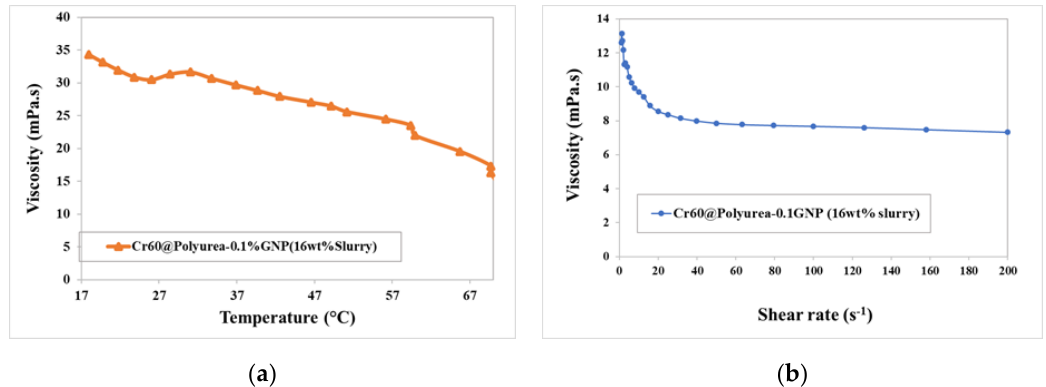
Figure 7. Rheological behavior of 16 wt % Cr60@Polyurea-0.1%GNP slurry ( a ) viscosity versus shear rate at 25 °C; ( b ) viscosity versus temperature at constant shear rate 10 s − 1 .